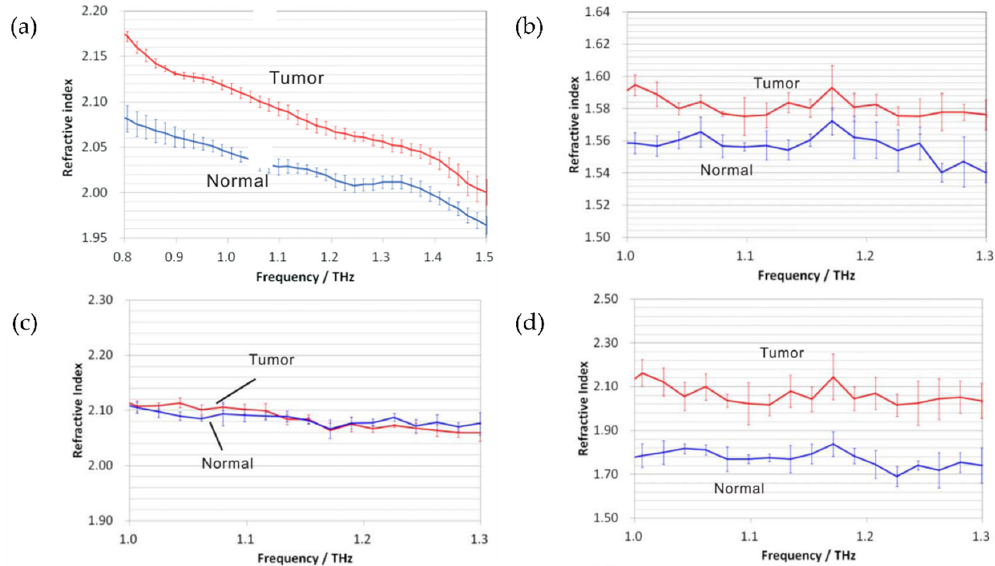
Figure 5. Refractive index spectra: ( a ) Fresh normal and tumor tissues; ( b ) fixed and paraffin-embedded normal and tumor